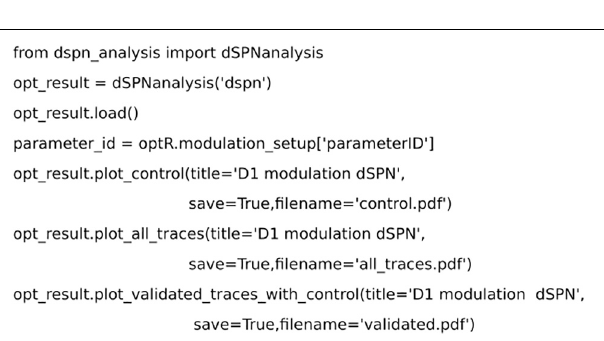
FIGURE 5 | Code for running the optimization.